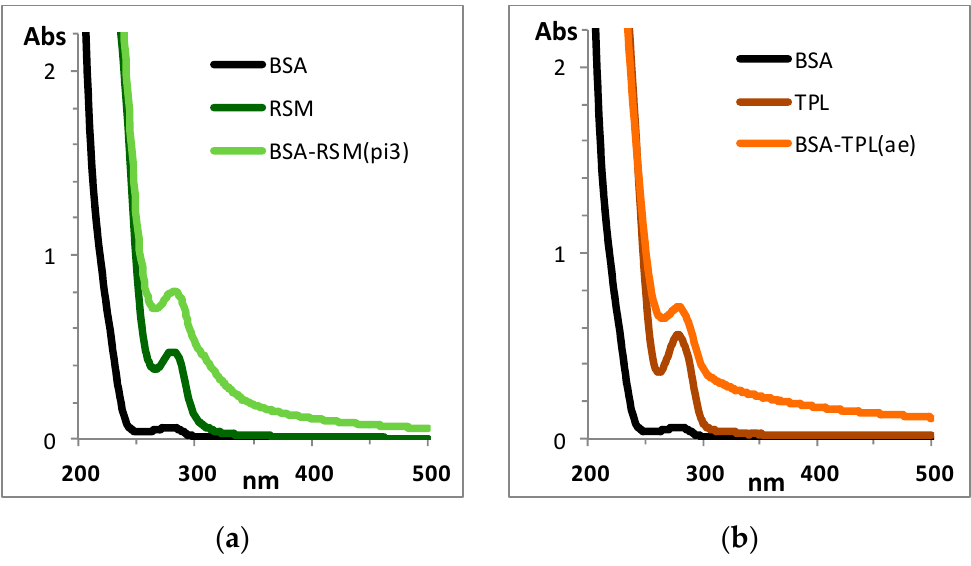
Figure 2. UV-spectra of protein carrier bovine serum albumin (BSA), immunogens, haptens RSM ( a ) and TPL ( b ). Coupling method is indicated in brackets, pi3—periodate (3-fold molar excess) oxidation, ae—active ester method. Concentration of all reagents was 0.1 mg/mL.